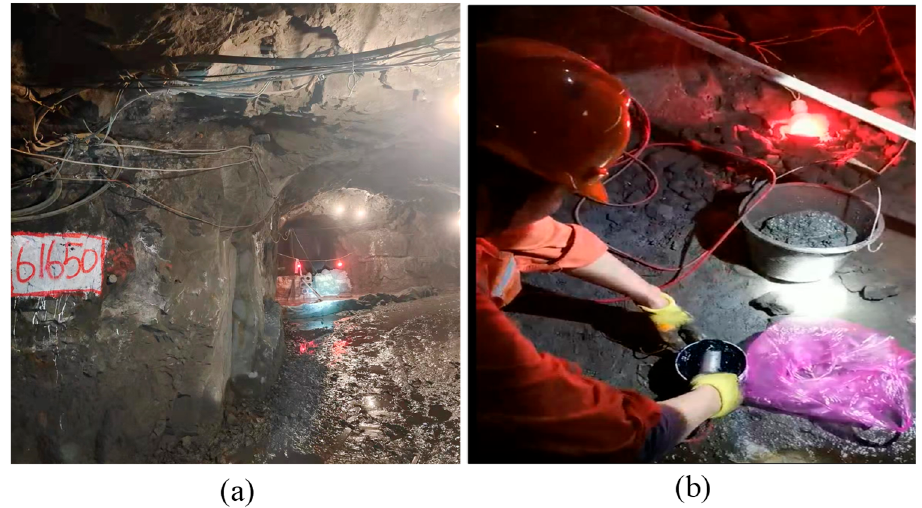
Figure 2. Line installation and layout. ( a ) Optical fiber transmission line erection; ( b ) installation of monitoring probe.